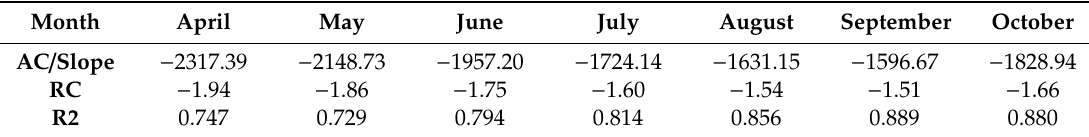
Figure 9. The changes in water area for each month across the year in the arid and semi-arid regions of central Asia. Table 3. The statistics of the change pattern for Figure 9.